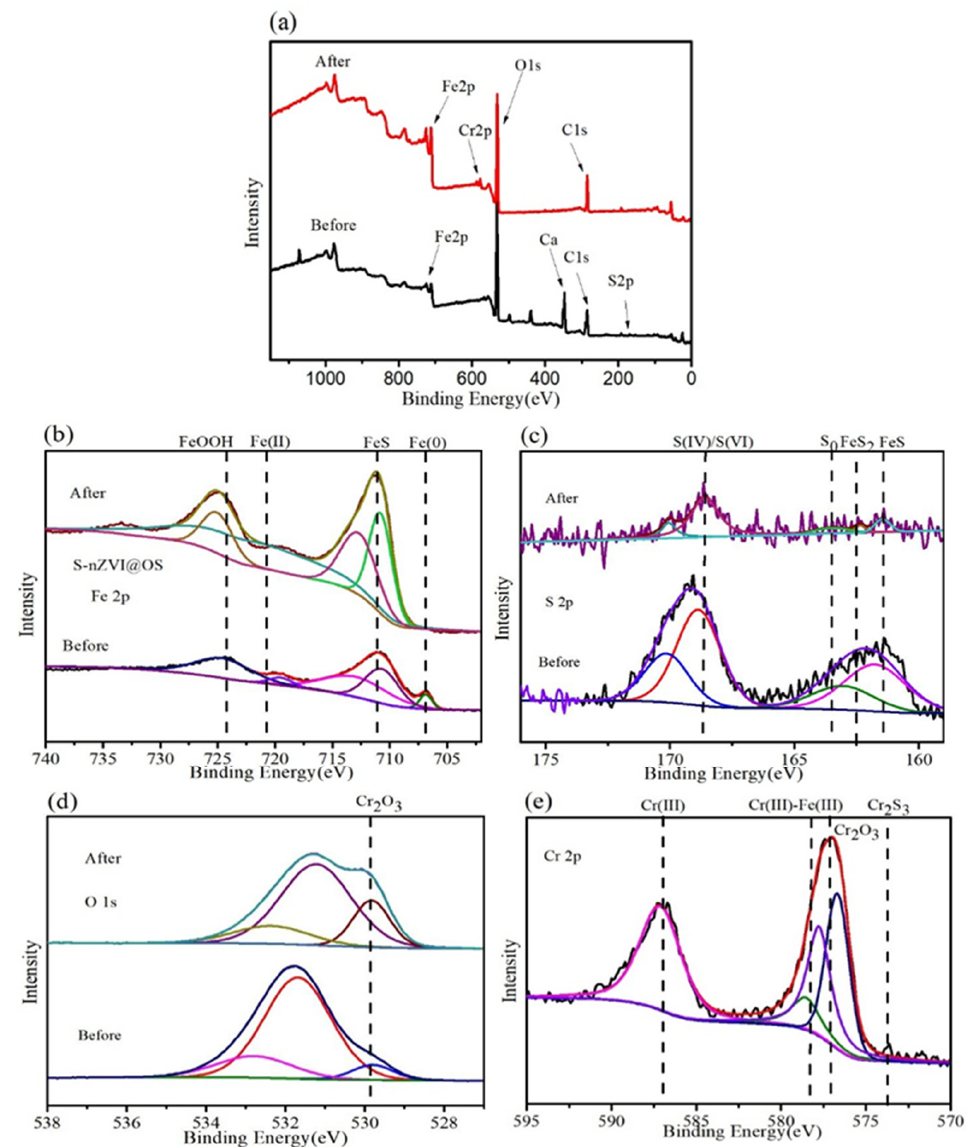
Figure 9. ( a ) XPS survey of S-nZVI@OS before and after reaction with Cr (VI); ( b ) Fe2p spectra before and after reaction; ( c ) S2p spectra before and after reaction; ( d ) O1s spectra before and after reaction; ( e ) Cr2p spectrum.